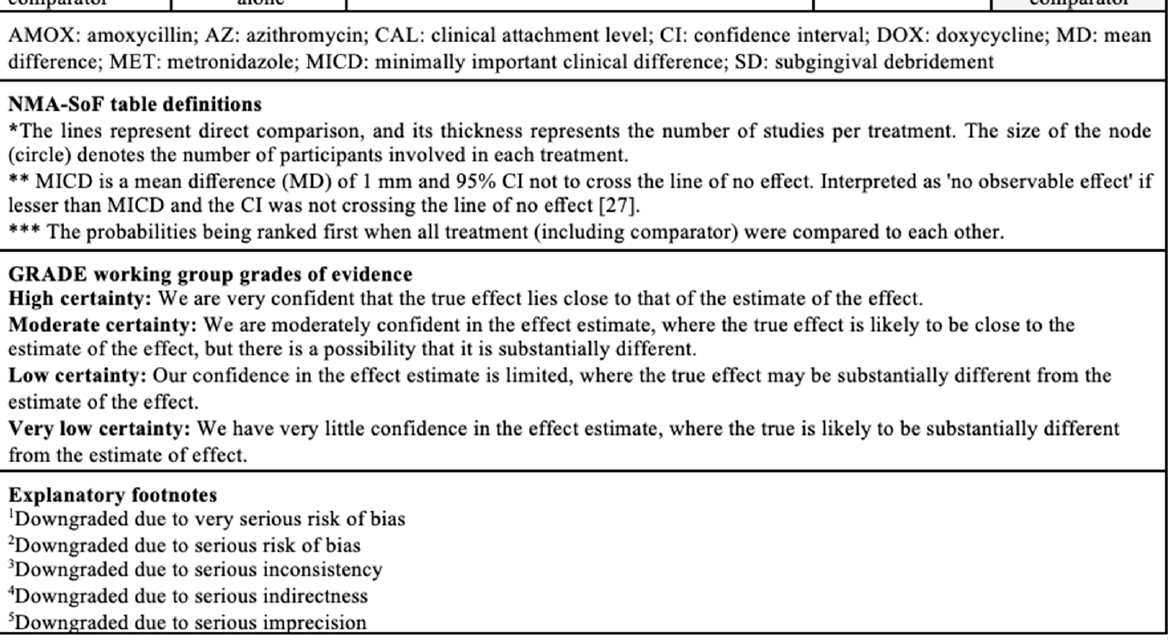
Figure 8. Summary of findings for long-term CAL gain following the use of systemic antibiotics adjunctive to subgingival debridement.